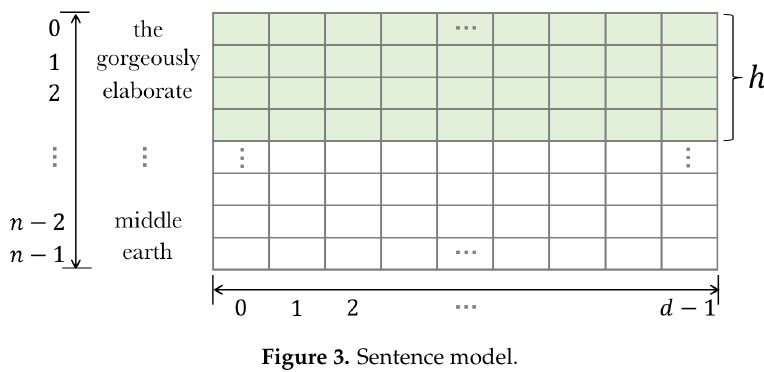
Figure 3. Sentence